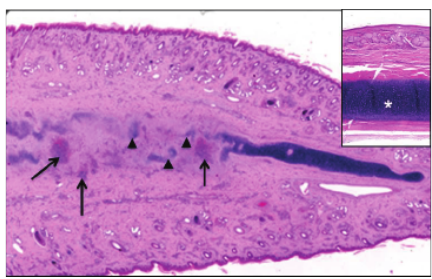
Figure 2: Histopathological features of auricular chondritis. The pinna is markedly expanded and the cartilage plate is disrupted (arrow heads) by multifocal to coalescing inflammatory infiltrates (arrows).Insetshowsasectionofpinnafromanunaffectedcowwith normal cartilage plate ( ∗ ). Hematoxylin and eosin: 1.25x.